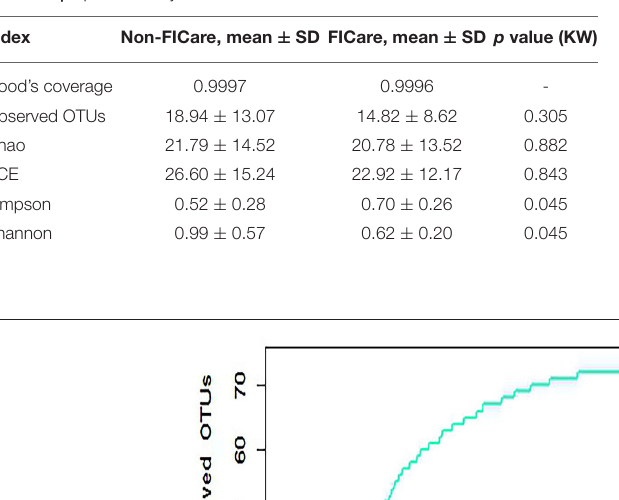
TABLE 6 | Alpha diversity statistical results.